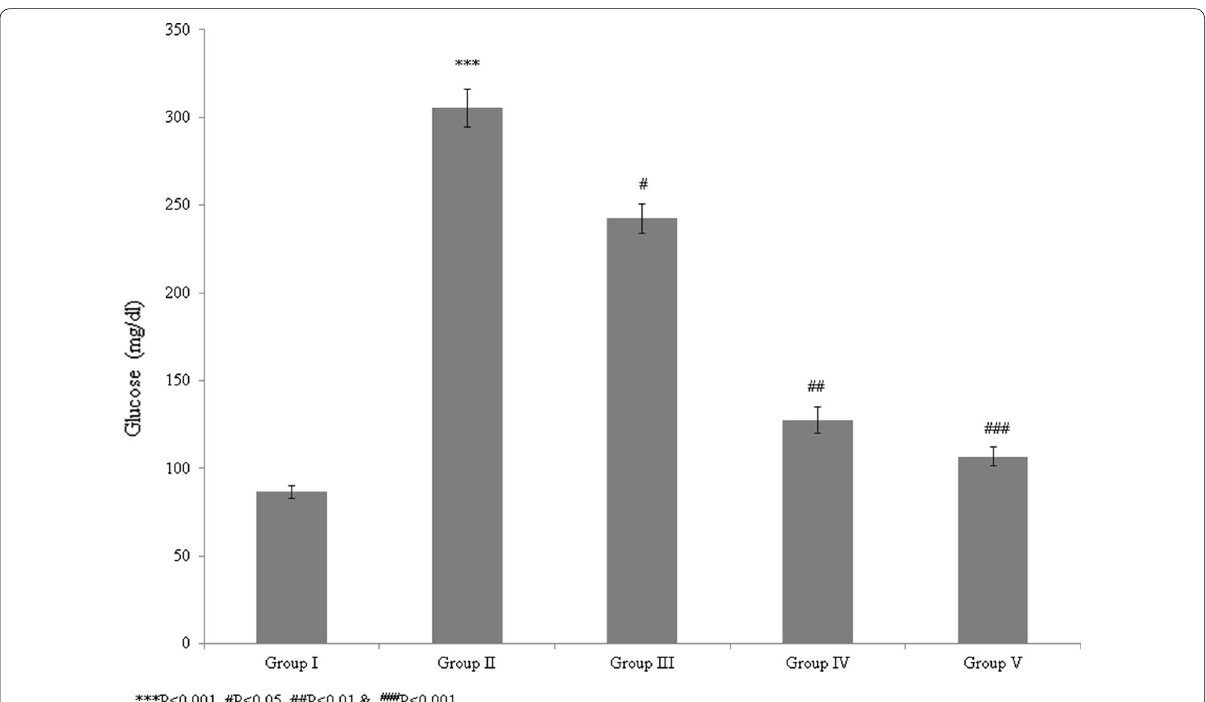
Fig. 1 Protective effect of a T. portulacastrum extract on serum blood glucose levels (mg/dL) in normal diabetic rats. *** P < 0.001 vs. sham; # P < 0.05, ## P < 0.01, and ### P < 0.001 vs. control. N =